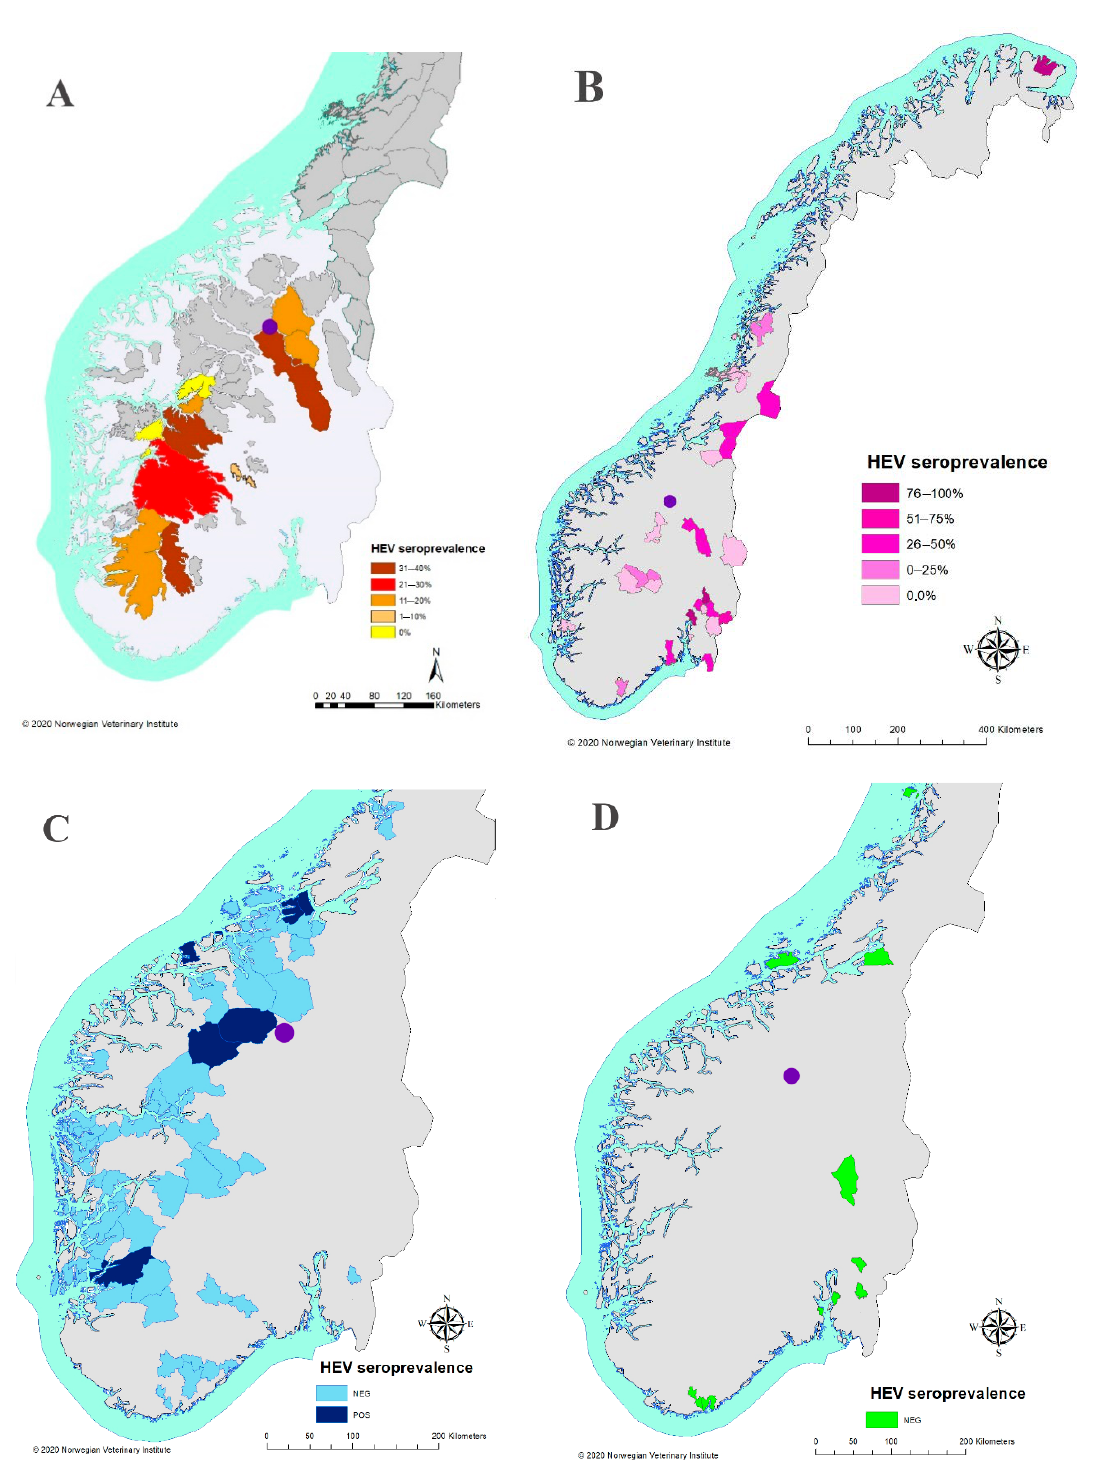
Figure 1. Overview of the origin of samples and prevalence results for Hepatitis E in this study. ( A ) Eurasian tundra reindeer ( Rangifer tarandus ); ( B ) moose ( Alces alces ); ( C ) red deer ( Cervus elaphus ); ( D ) European roe deer ( Capreolus capreolus ). All muskoxen ( Ovibos moschatus ) originated from Dovrefjell National Park, and this area is identified with a purple circle on every map. For information on the geographic units used on the maps, please refer to a higher format version of these in the Supplementary Materials (Supplementary Figure S1A–D). Note that for some cases, the geographical origin was not recorded; therefore, the total number of cases does not necessarily coincide with the number of cases represented.